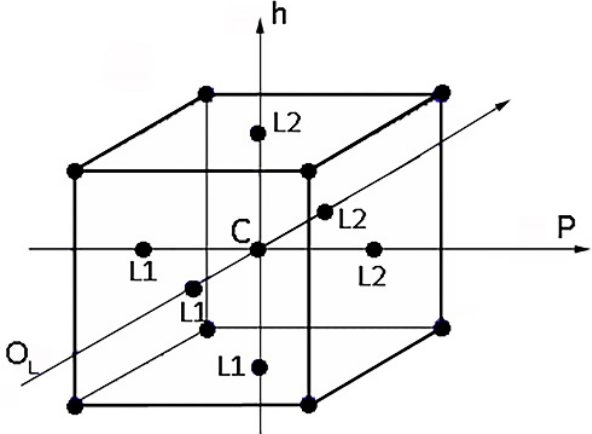
Table 2. Process parameters adopted and levels for laser setup.